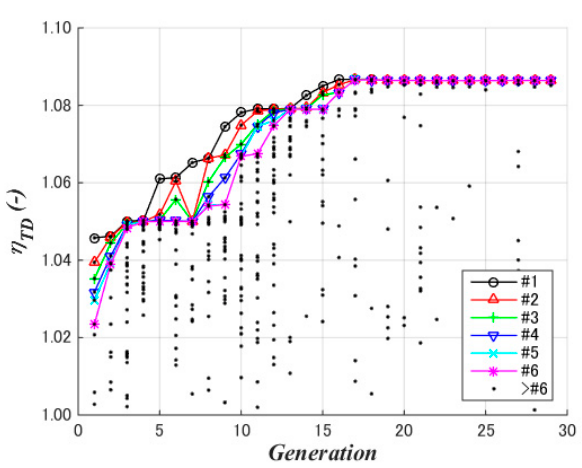
Figure 4. Optimization progress, with marked lines for top six data.